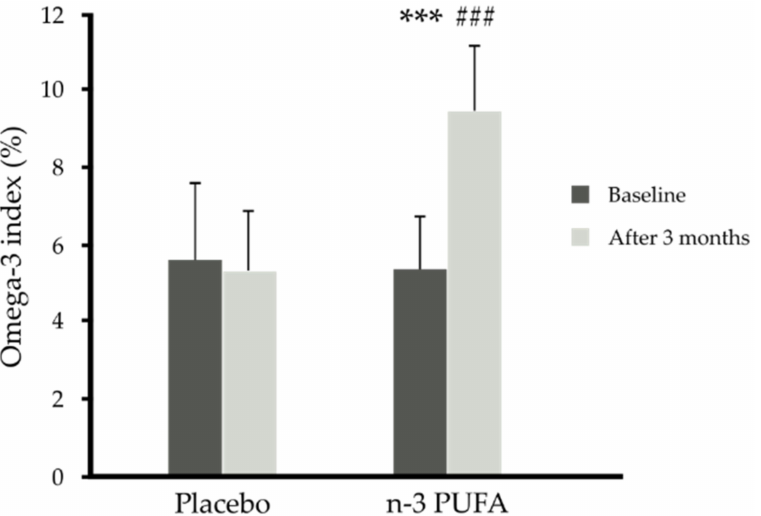
Figure 2. Omega 3 index (weight%) before and after 3 months of n-3 PUFA ( n = 26) or placebo ( n = 28) supplementation independent of diet. Data are shown as mean ± SD. Statistics: analyses were performed with repeated measures by ANOVA and Tukey post hoc test; significance: *** p < 0.001 after versus before n-3 PUFA supplementation, ### p < 0.001 after n-3 PUFA supplementation versus after placebo supplementation.